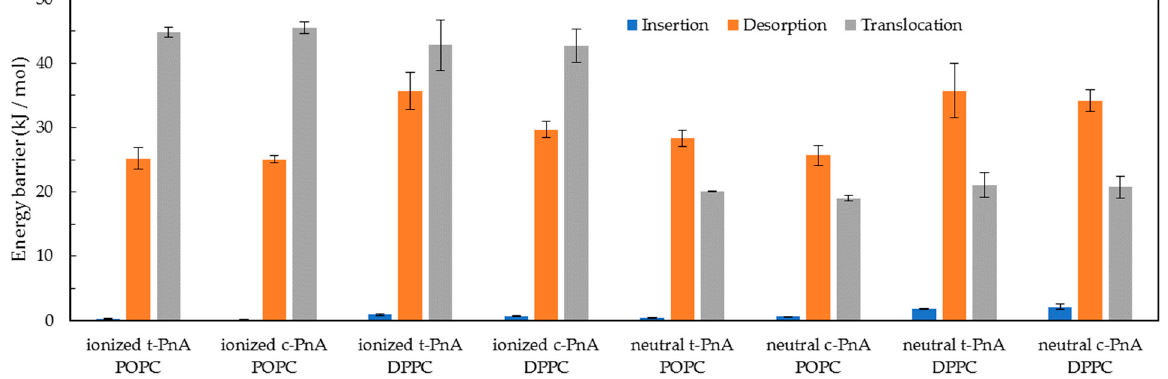
Figure 12. Energy barriers for the insertion (blue), desorption (orange) and translocation (gray) pro ‐ cesses of ionized and neutral t ‐ PnA and c ‐ PnA in POPC and DPPC lipid bilayers.